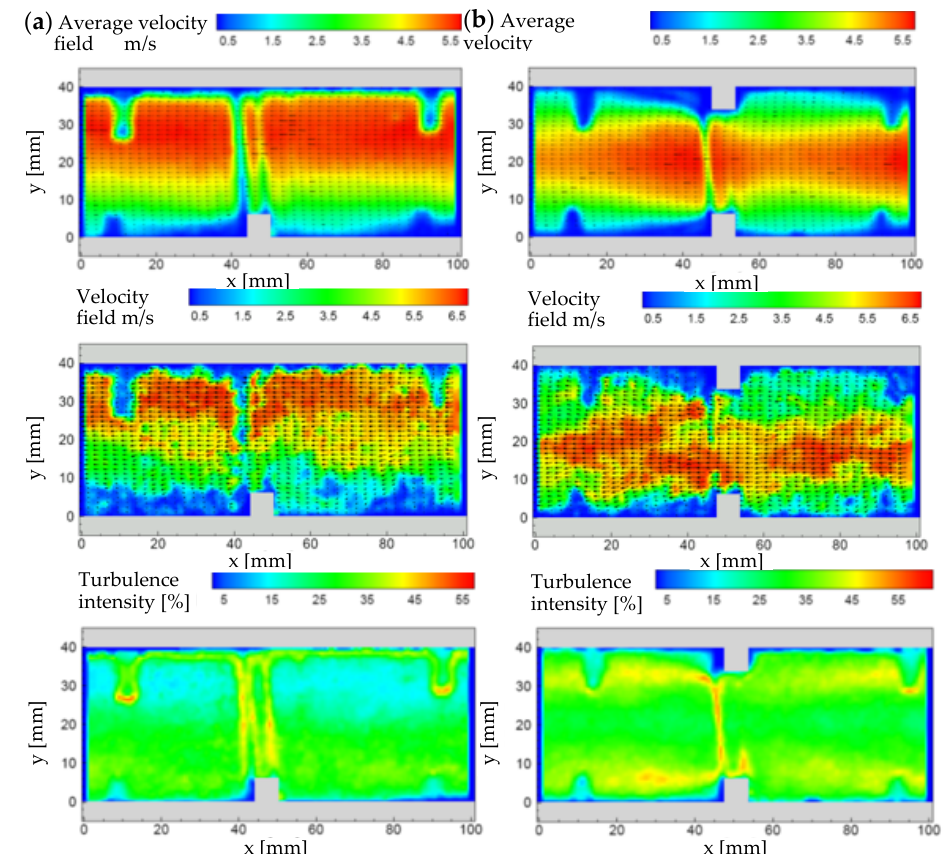
Figure 16. PIV measurements for ribbed channel P/e = 11 (configuration_1 ( a ) and configuration_2 ( b )) and Re = 16,000: averaged velocity field, velocity field and turbulence intensity.